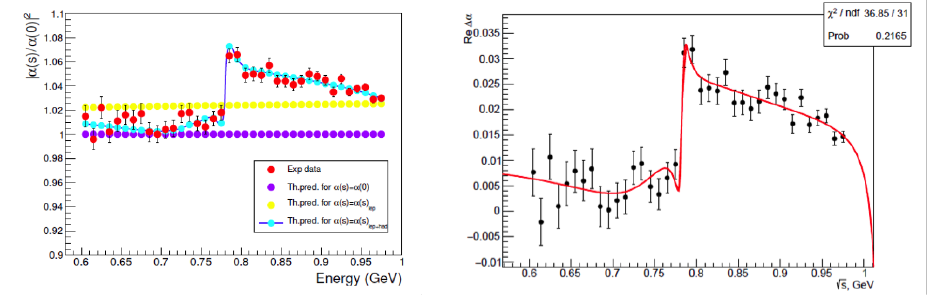
Figure 6. Running of α em (left), and (cid:60) ( ∆ α ) (right), showing the ρ − ω contribution to the photon